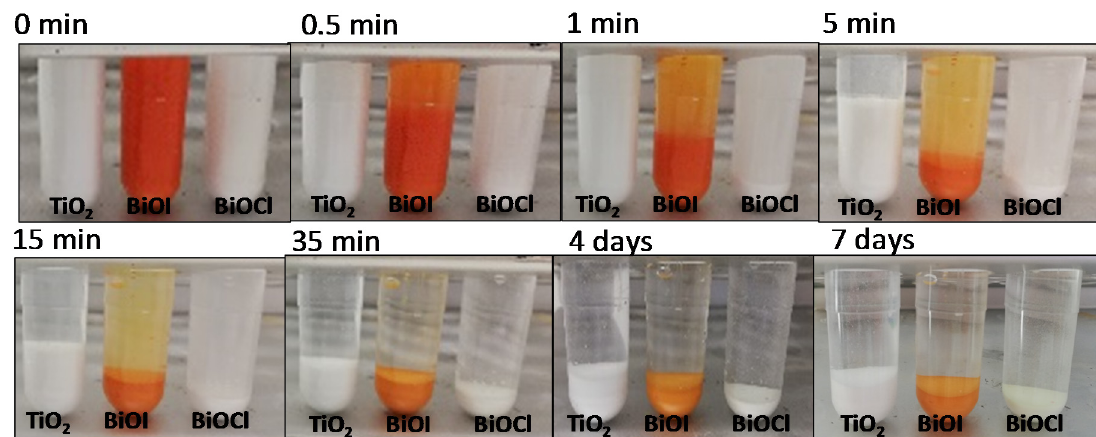
Figure 3. Sedimentation test for photocatalysts in the synthetic cement-pore solution.